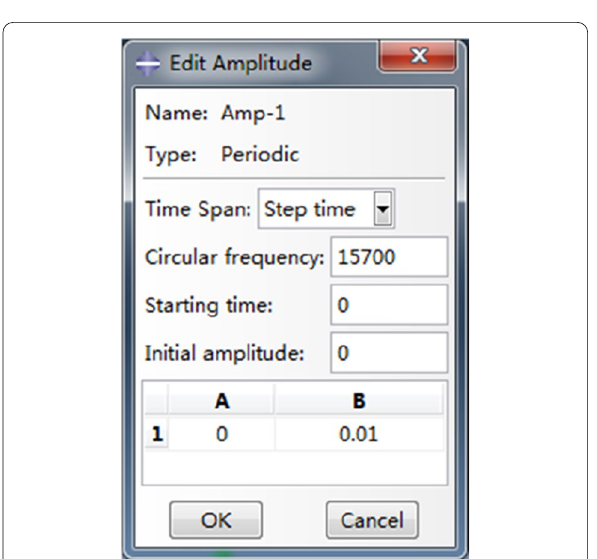
Figure 6 is the imitated diagram of surface roughness